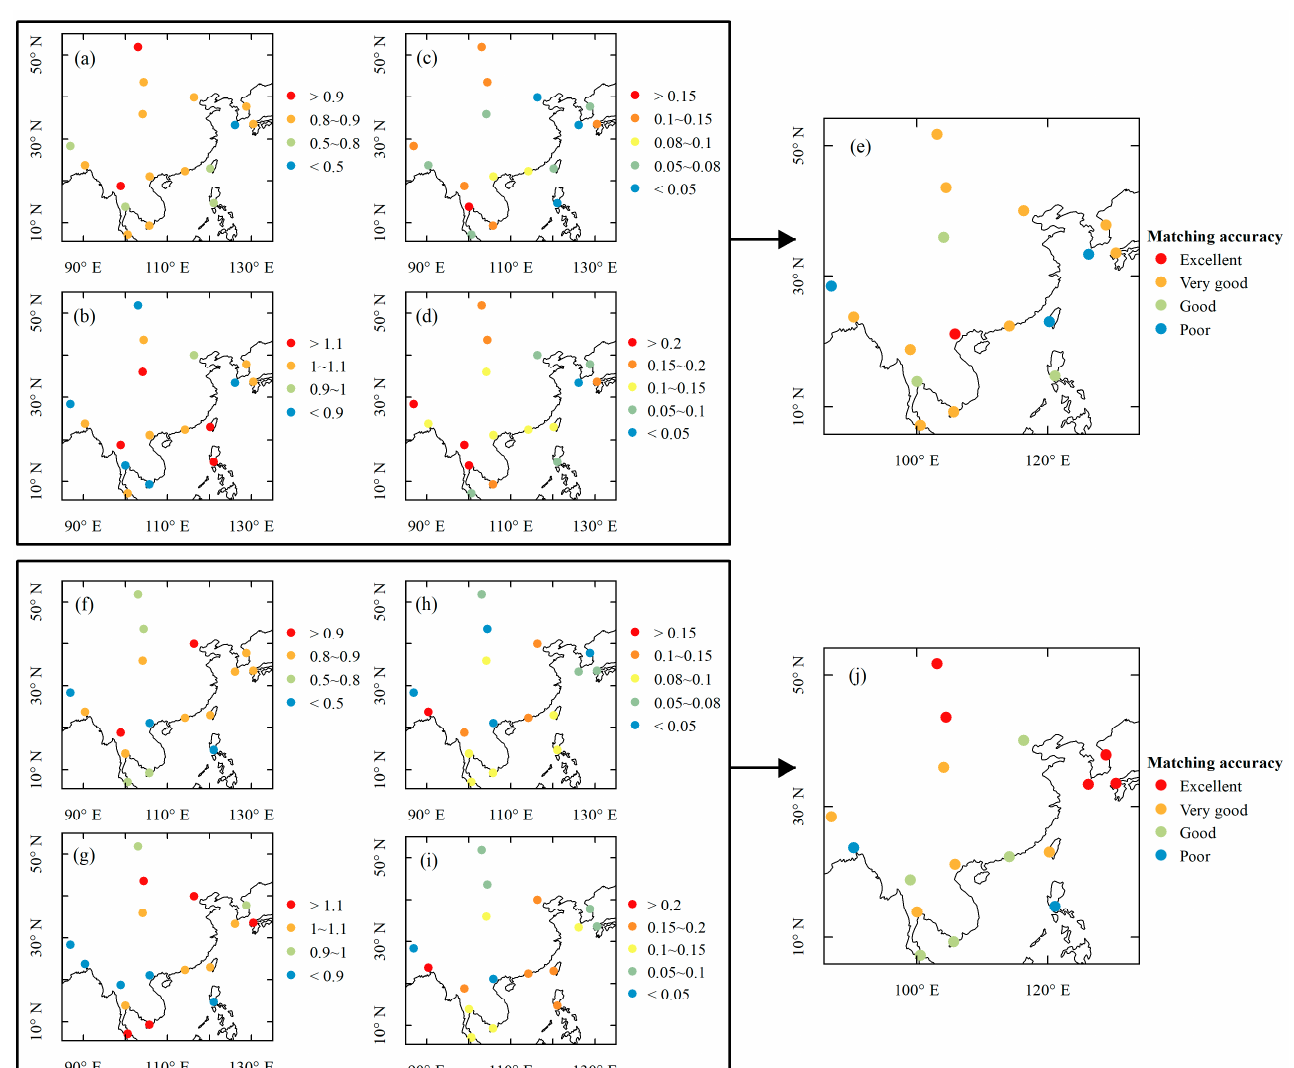
Figure 3. Accuracy of AOD observations for MAIAC Terra ( a – e ) and Aqua ( f – j ) against AERONET measurements at each site. ( a , f ) R; ( b , g ) RMB; ( c , h ) MAE; ( d , i ) RMSE; ( e , j ) Matching